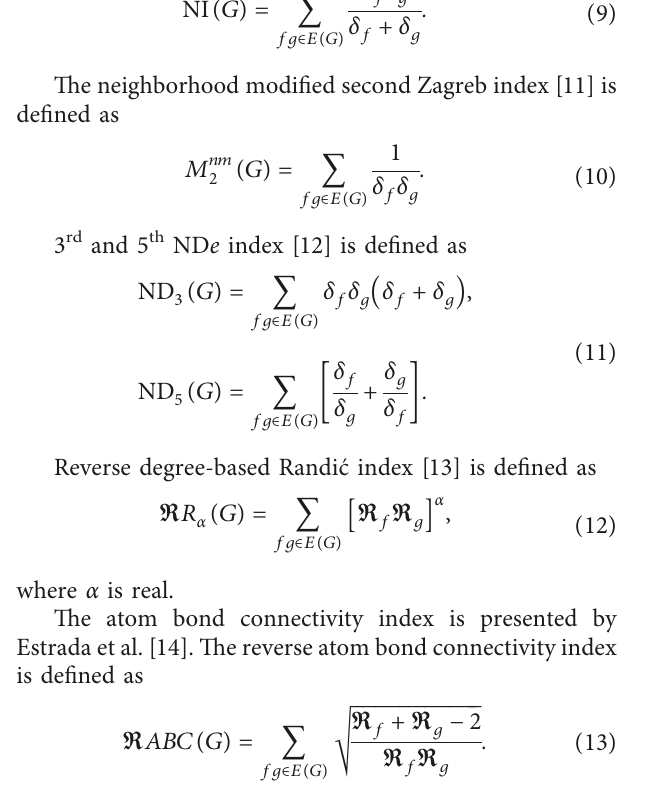
Figure 1: HEX unit